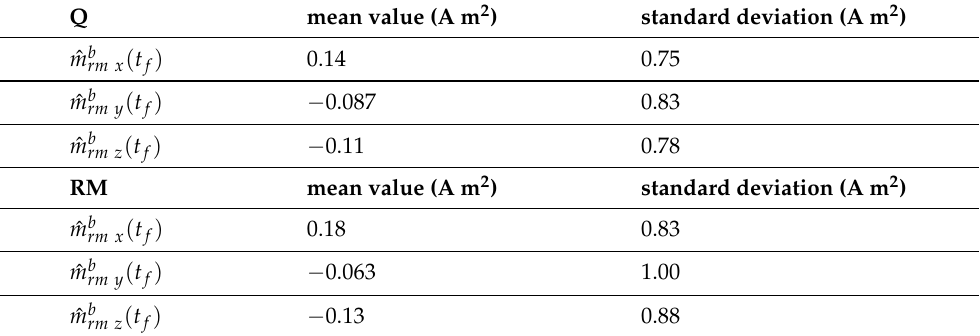
Table A2. Statistics on ˆ m b rm ( t f ) from the Monte Carlo campaign for the perturbed case using either quaternion feedback (Q) or rotation matrix feedback (RM). In the campaign, the residual magnetic dipole moment is constant and equal to m b rm = [ 0.15 − 0.12 − 0.1 ] T (see Table 3). Q mean value (A m 2 )